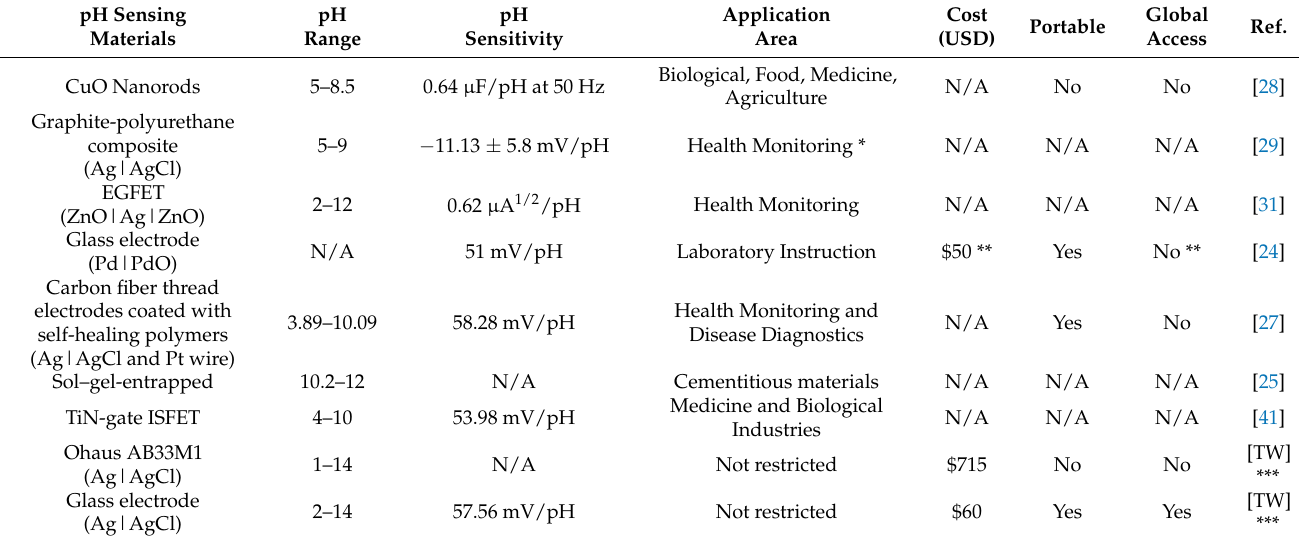
Table 3. Comparison of pH sensor features as required for global